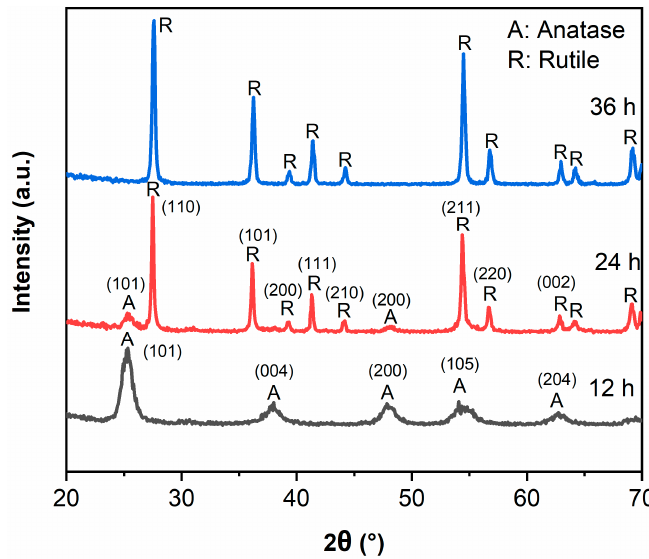
Figure 1. XRD patterns of TiO 2 -12 h, TiO 2 -24 h and TiO 2 -36 h.